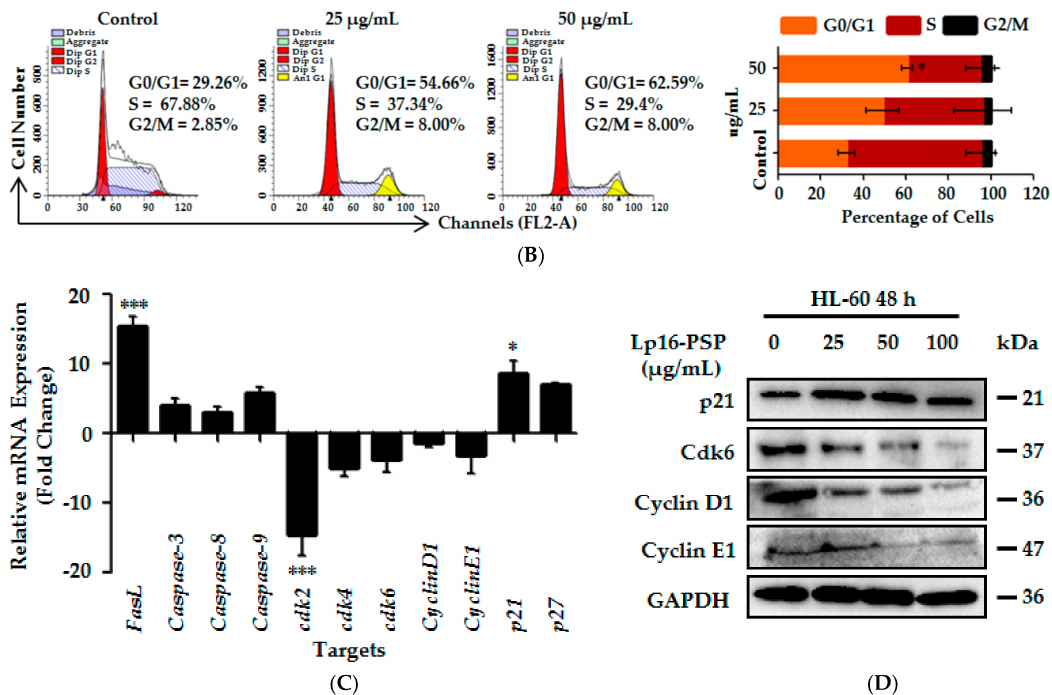
Figure 3. Lp16-PSP suppressed the anchorage-independent growth and Induced p21 WAF1/CIP1 - mediated G 1 cell cycle arrest in HL-60 cells. ( A ) The effect of non-toxic concentrations of Lp16-PSP (0, 12.5, 25 and 50 µ g/mL) on colony formation (anchorage-independent growth) of HL-60 cells was evaluated at 40 × magnification and a number of colonies were counted as described in Materials and Methods. The data reported here is the mean ± SD of three separate experiments, * p < 0.05, ** p < 0.01; ( B ) HL-60 cells untreated and treated with various concentrations of Lp16-PSP for 48 h were analyzed for DNA content using flow cytometry. To the left are the results of the one representative experiment indicating the distribution and percentages of cells in G0/G 1 , S and G2/M phase. To the right is the graphical presentation of the distribution and percentages of cells in different phases of the cell cycle. The data presented here are the means ± SD of three independent experiments where * p < 0.05; ( C ) qRT-PCR analysis of apoptosis- and cell cycle-related genes. The data presented here are the means ± SD of two independent experiments each run in triplicate, where * p < 0.05, *** p < 0.001; and ( D ) Western blot of cell cycle-related proteins after Lp16-PSP treatment with indicated concentrations for 48 h. GAPDH was used as the internal control. Western blots are representative of three independent